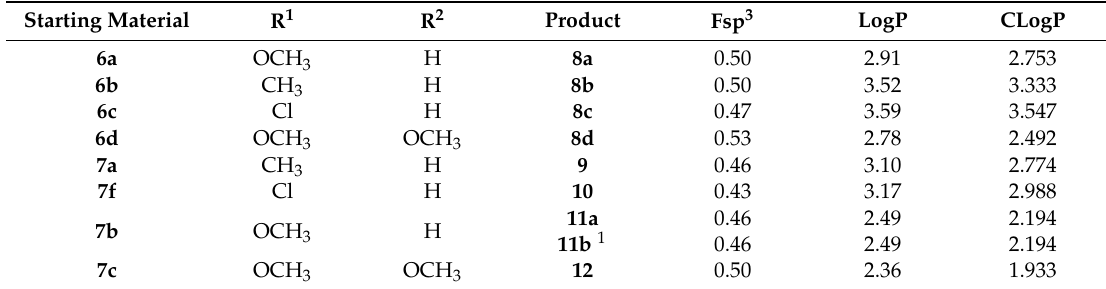
Table 2. Fsp 3 values of